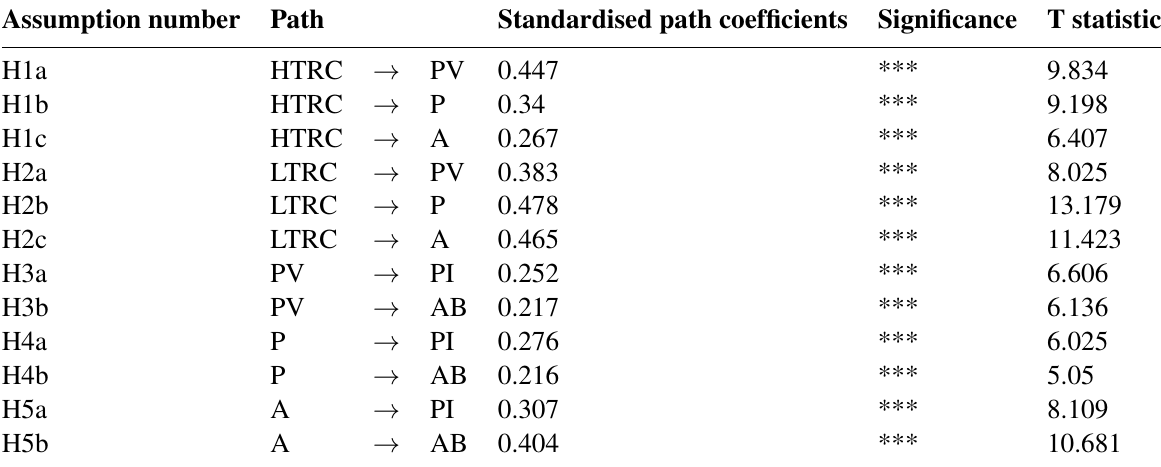
Table 5 Modified path coefficient and its